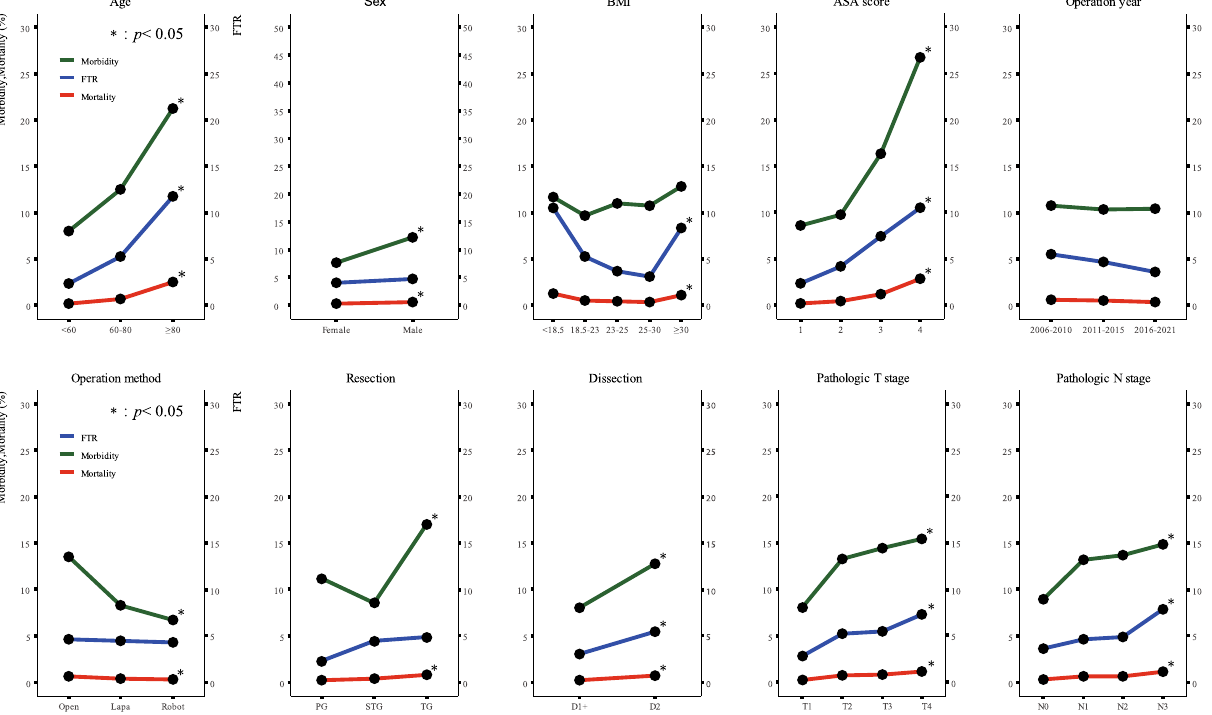
Figure 2. Morbidity, mortality, and failure to rescue (FTR) according to clinicopathologic and surgical factor (groups were compared using the Chi-square test or Fisher’s exact test. * P < 0.05. Green and red lines represent morbidity and mortality rates, respectively, and are displayed on the left axis. The blue line indicates the FTR rate and is displayed on the right